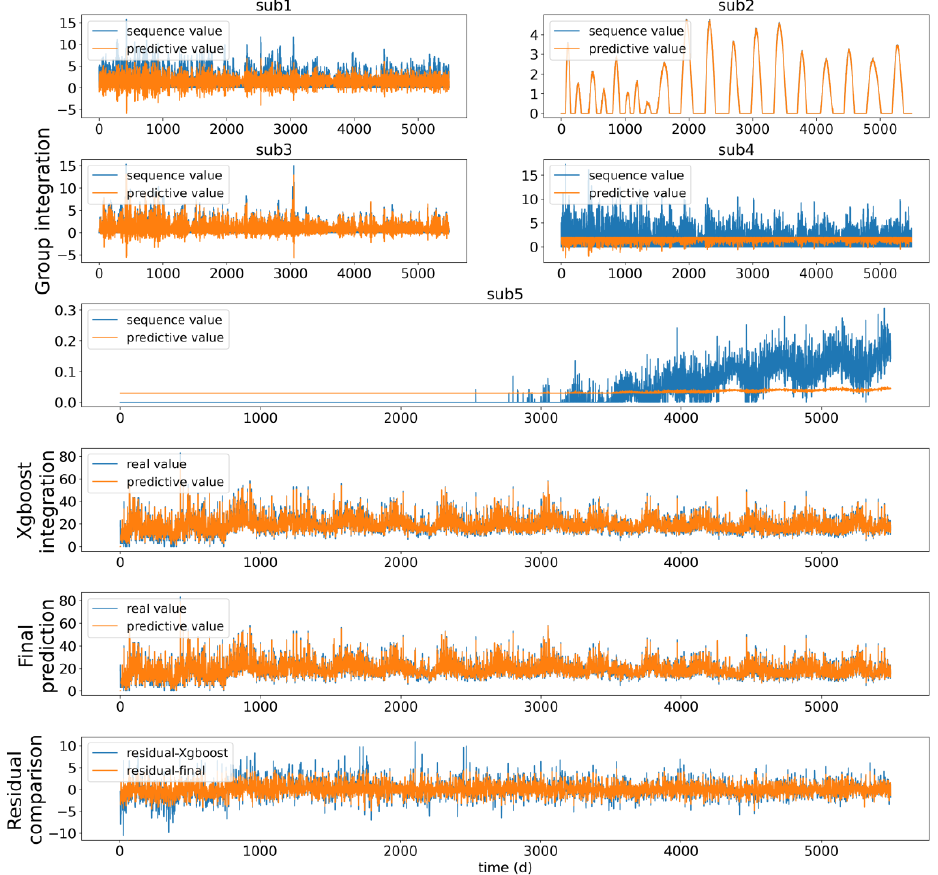
Figure 18. The first five subfigures are the point prediction results of subseries. The sixth subfigure titled “Xgboost integration” shows the integrated results. The seventh subfigure represents the final point prediction results which are generated based on the Xgboost integration and error correction strategy. The last subfigure is the residual comparison between the model with error correction strategy and the model without it. All the experimental results here used data in case 4. The parameters are shown in Table 6.